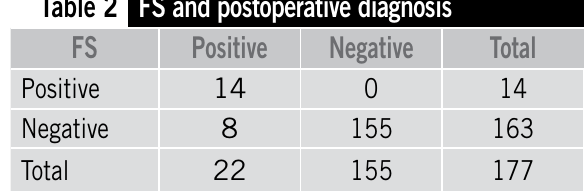
FS: Intraoperative frozen section